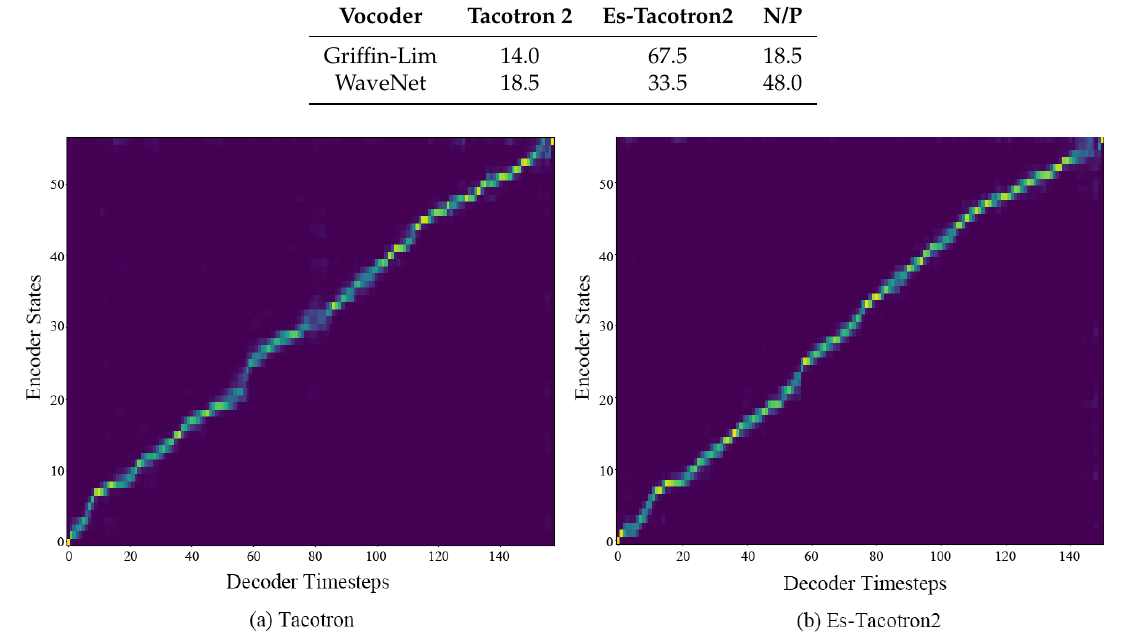
Figure 8. The alignment comparison of original Tacotron 2 and Es-Tacotron2 with a sentence “had the oddest effect the work was beautifully